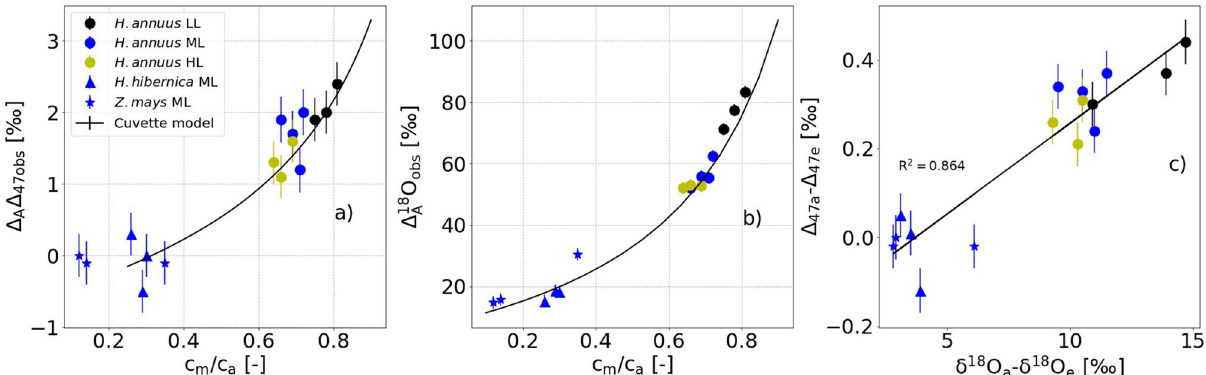
Figure 6. Effect of photosynthetic gas exchange on Δ 47 and δ 18 O of CO 2 . Δ A Δ 47 ( a ) and Δ A18 O ( b ) during photosynthetic gas exchange experiments as a function of the c m / c a ratio. (LL = low light: PPFD = 200 μmol m − 2 s −1 , ML = medium light: PPFD = 700 μmol m −2 s −1 , HL = high light: PPFD = 1800 μmol m −2 s −1 ). a) discrimination against 13 C 18 O 16 O (Δ A Δ 47 ). ( b ) discrimination against 12 C 18 O 16